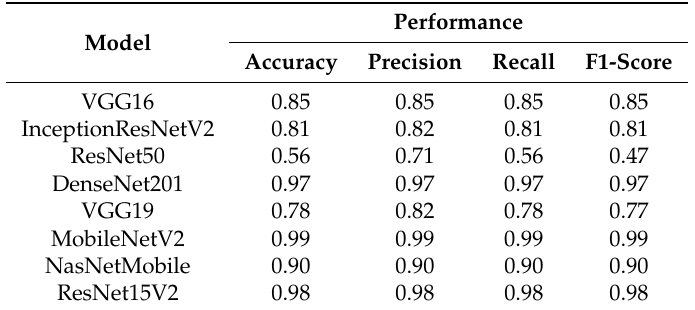
Table 2. Overall model’s performance on CT scan train set.